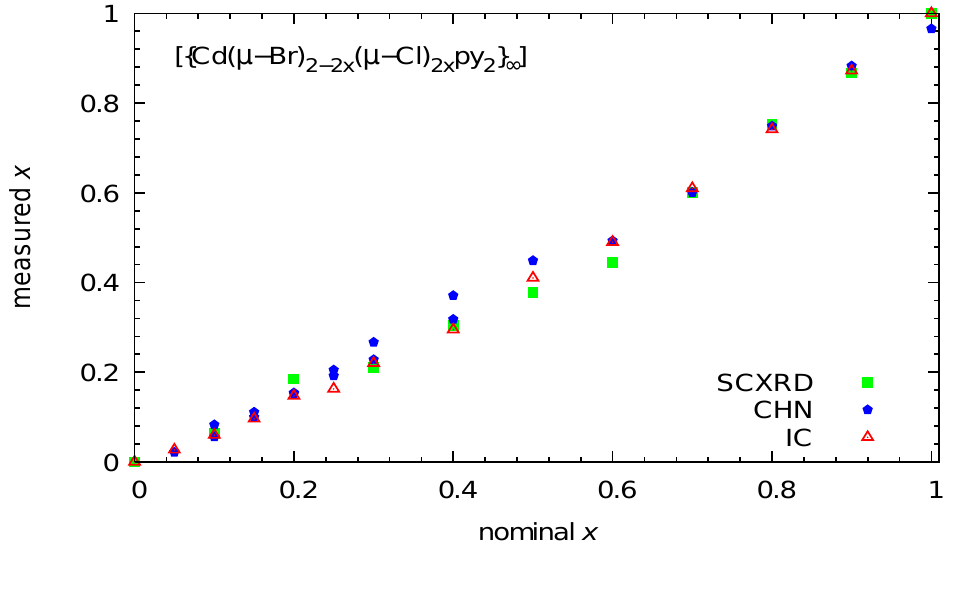
Figure 3. X-ray powder diffractograms of 1 30 , 1 70 and 2 at ambient temperature showing a shift towards higher diffraction angles with increasing chlorine